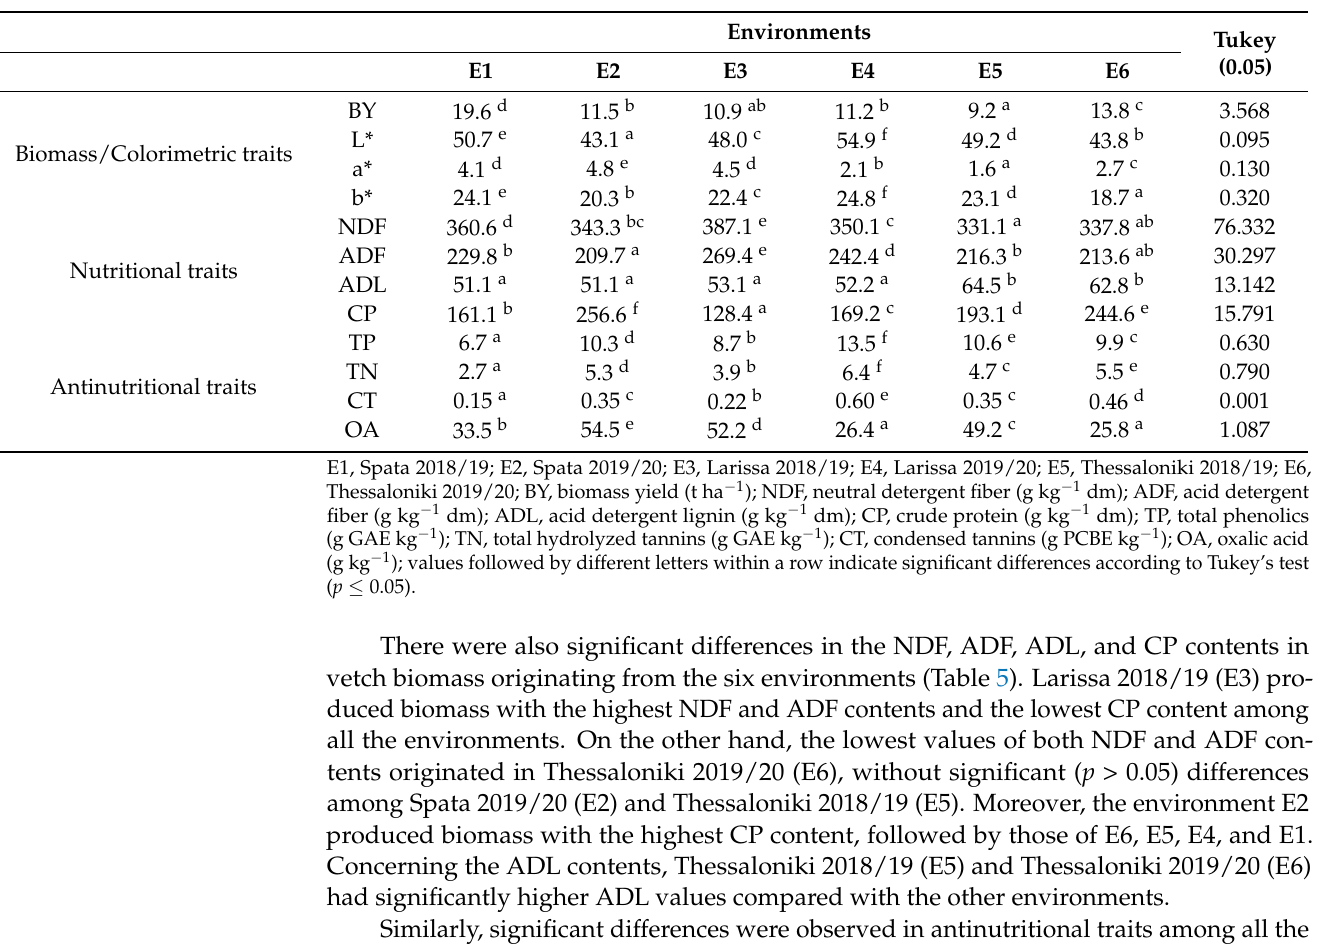
Table 5. Variation in biomass/colorimetric, nutritional and antinutritional traits of V. sativa biomass originated from six environments averaged across seven